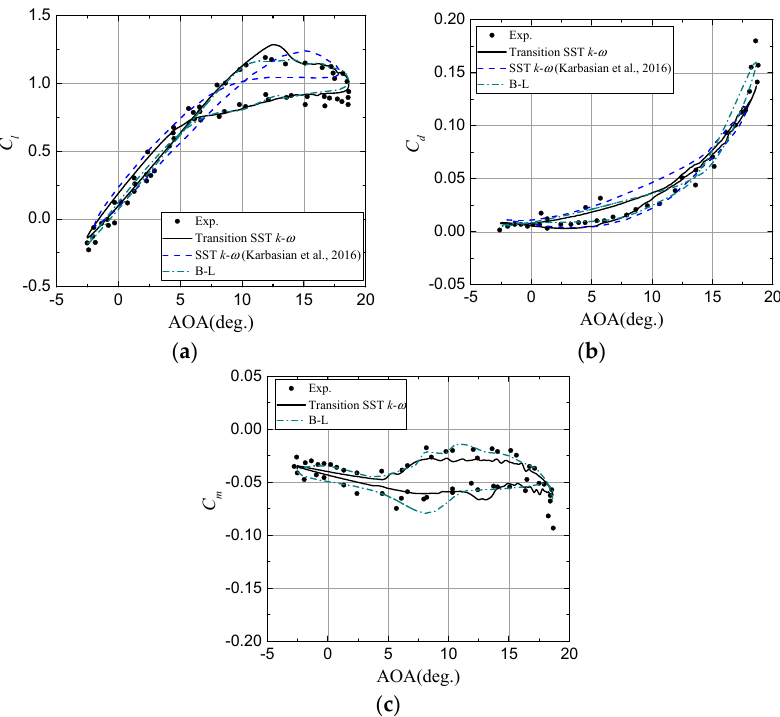
Figure 8. Comparison of aerodynamic coefficients under pitch oscillation. α m = 8°, A = 10°, and k = 0.026. ( a ) The lift coefficient; ( b ) The drag coefficient; ( c ) The pitching moment coefficient.